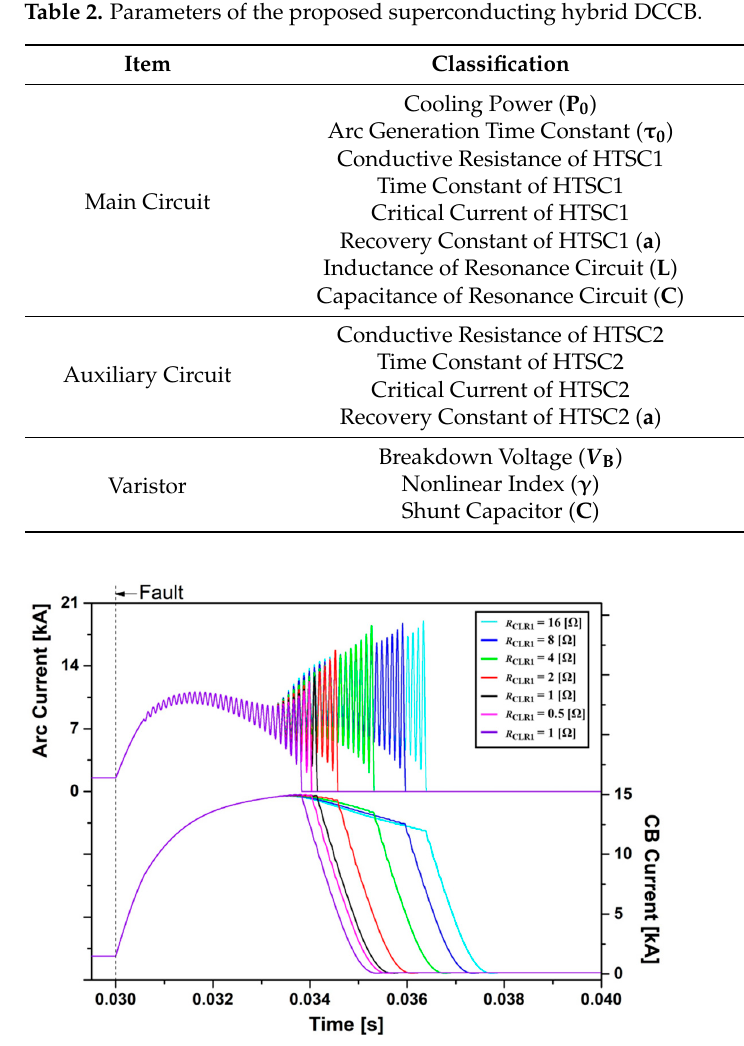
Figure 6. The waveform of DCCB current ( i DCCB ) and arc current ( i arc ) in the case where CLR1 is set to Inductance 2 (mH) and CLR2 is set to Resistance 0, 0.5, 1, 2, 4, 8, 16 ( Ω ).